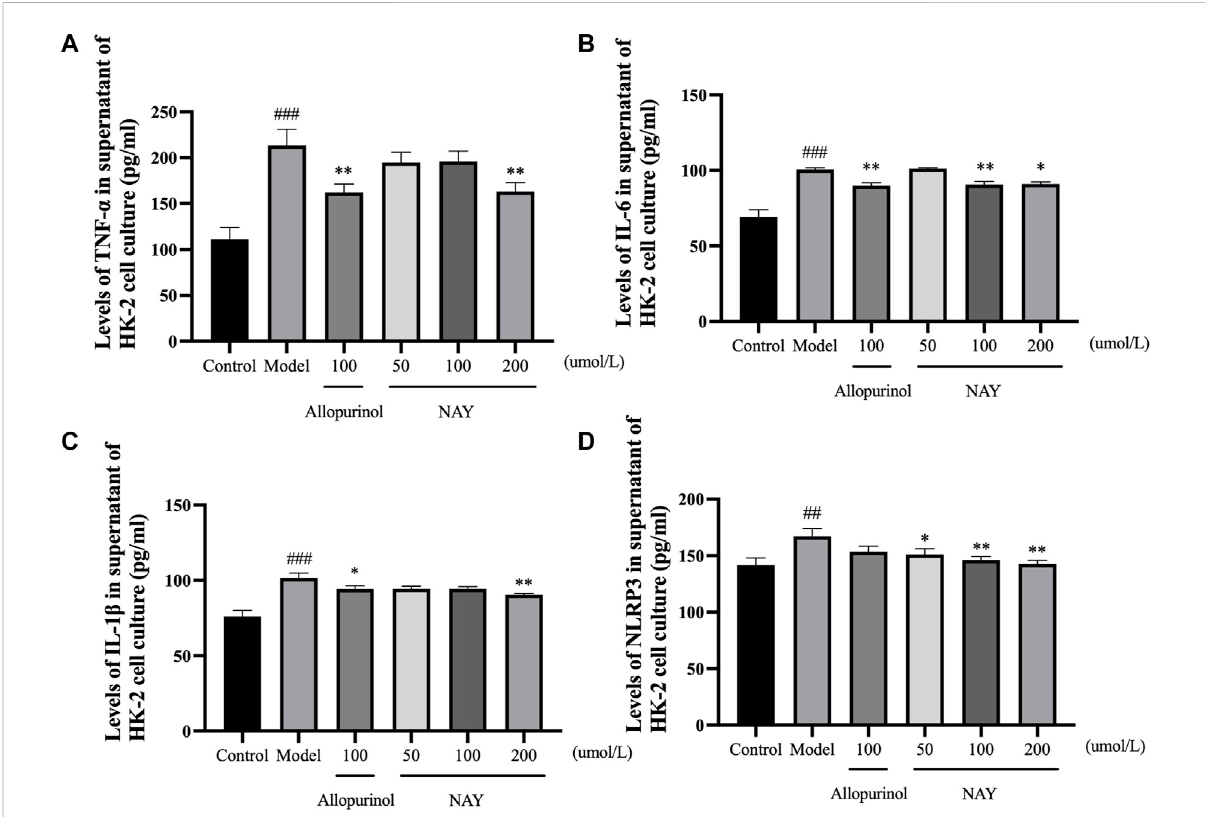
FIGURE 11 EffectsofNAYonTNF- α (A) ,IL-6 (B) ,IL-1 β (C) ,andNLRP3 (D) levelsinHK-2cellsculturemediumsupernatant.(Datawereexpressedasmean± S.E.M.; n = 5. Compared with the control group, # P < 0.05, ## P < 0.01, and ### P < 0.001. Compared with the model group, * P < 0.05, ** P < 0.01, and *** P <